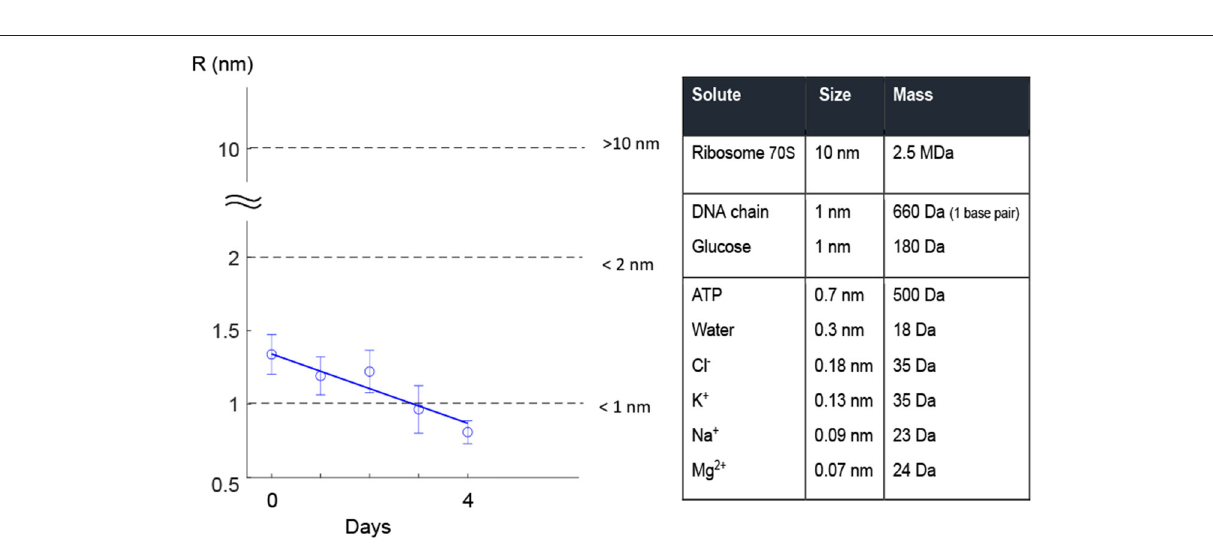
of parameters such as V cell (which was substituted from values specified for E. coli , Table 2